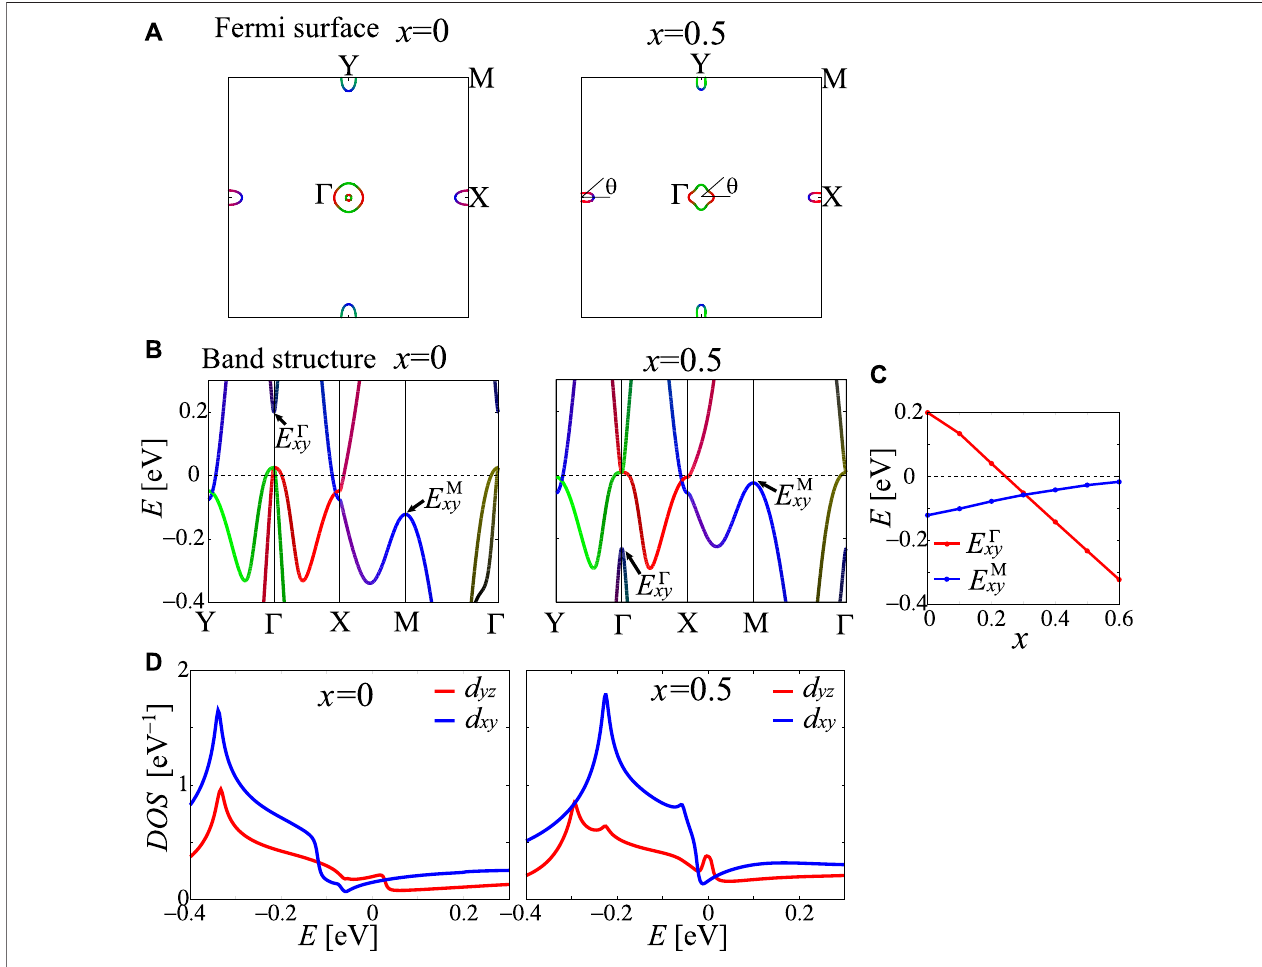
FIGURE 4 | (A) FSs and (B) band structures of FeSe 1 − x Te x for x = 0 and 0.5. (C) x dependences of E Γ xy and E M xy . (D) DOS of orbitals 3 and 4 for x = 0, 0.5.